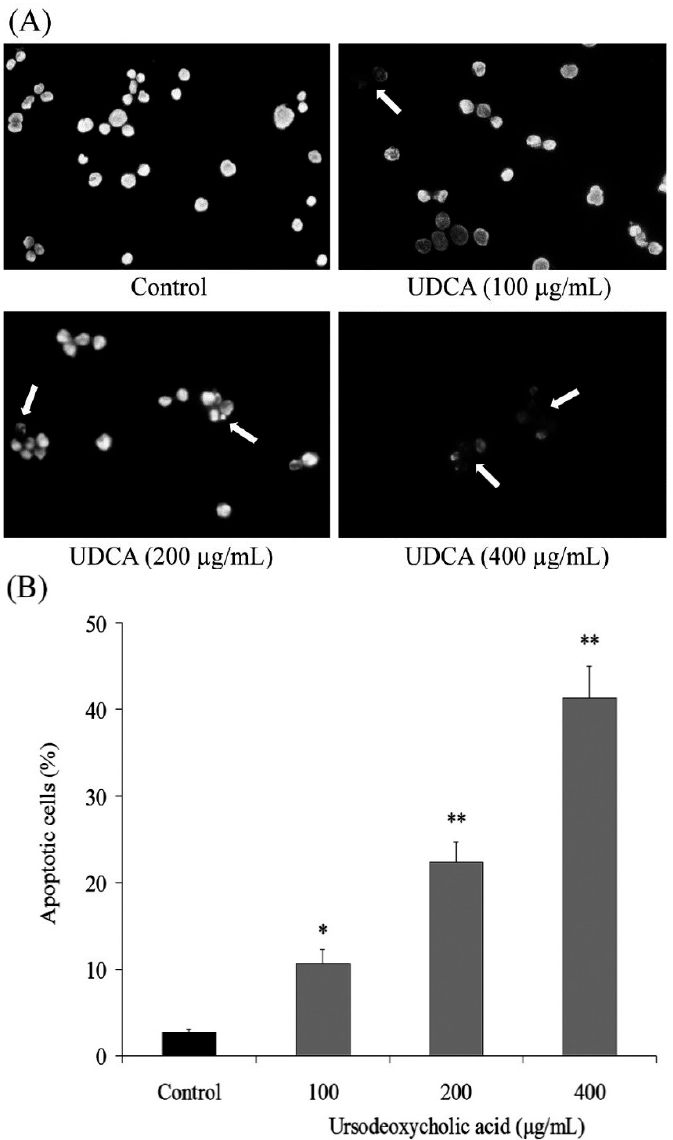
Figure 2. Exposure of human oral squamous carcinoma HSC-3 cells to ursodeoxycholic acid (UDCA) induced apoptosis. ( A ) Appearance of apoptotic bodies in HSC-3 cells treated with UDCA for 48 h (200×); and ( B ) treatment with UDCA for 48 h increased the number of apoptotic cells as measured by flow cytometry. The profile represents an increased sub-G1 population (apoptotic cells). * Mean values are significantly different from control ( p < 0.05) and ** mean values are significantly different from control ( p <